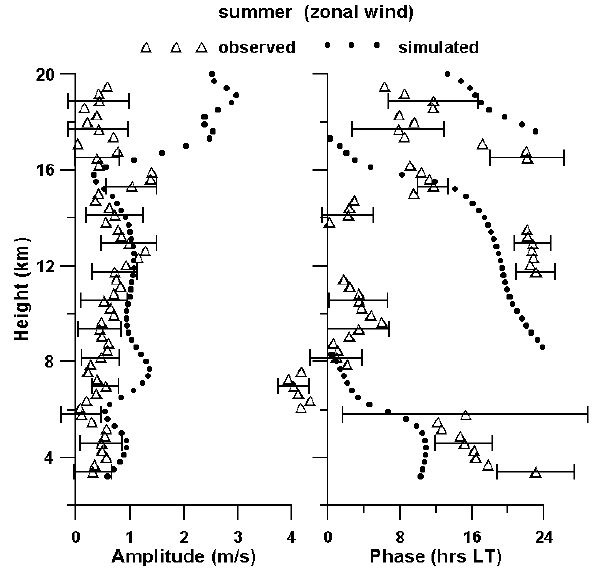
Fig. 8. Same as Fig. 2, but for the summer season. Fig. 9. Same as Fig. 3, but for the summer